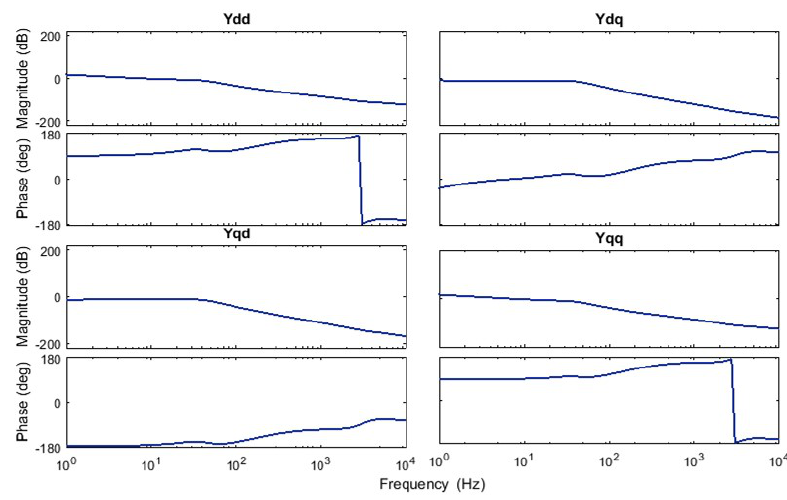
Figure 10. Bode plot of output admittance for droop-controlled inverter.